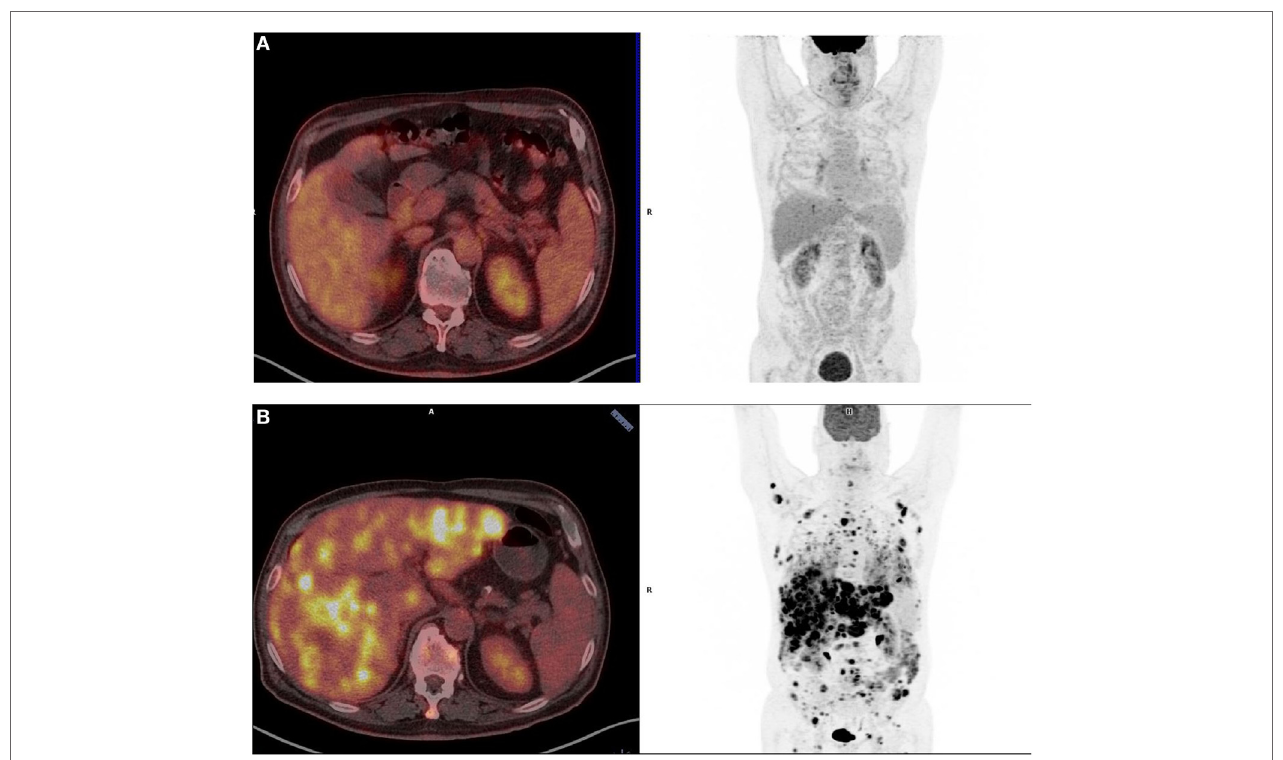
FIgURe 1 | Positron-emission tomography (PET)-scanner imaging at baseline (a) and after three cycles of pembrolizumab (B) . (a) Patient’s baseline PET scan (December 2016): only four infracentimetric hypermetabolic lung nodules are visible [standardized uptake values (SUV) from 2.2 to 5.5]. No evidence of distant metastases elsewhere. (B) Patient’s PET scan after three cycles of pembrolizumab (May 2017): diffuse and multiple hypermetabolic lung, liver, subcutaneous tissue, and peritoneal lesions (SUV from 3.5 to